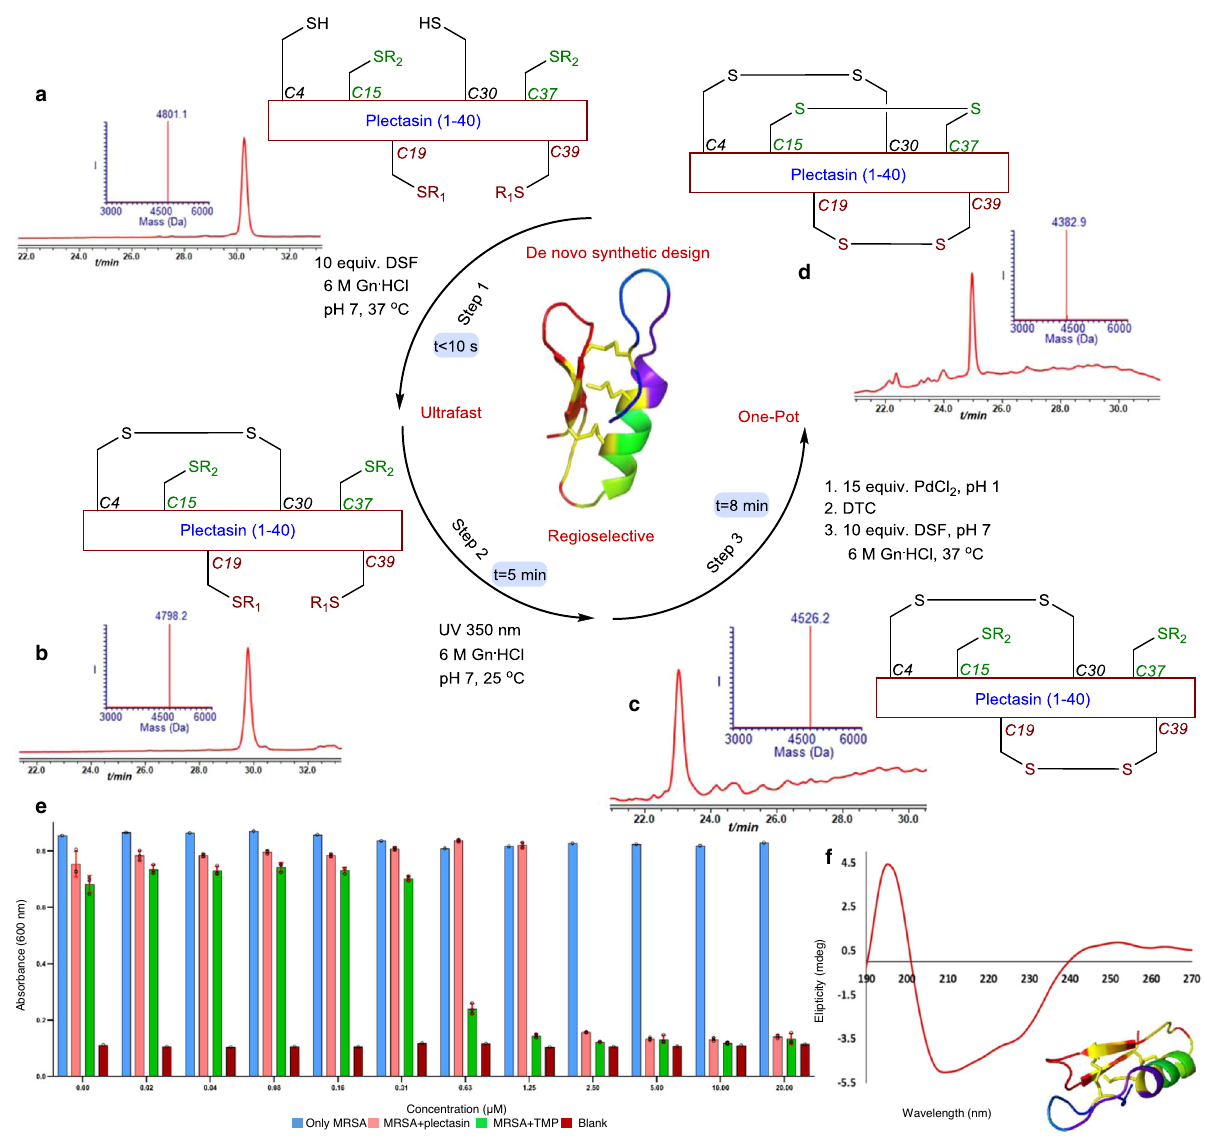
Fig. 4 Synthesis of plectasin employing our synthetic design. a HPLC-ESI MS analyses Reaction at time zero, the main peak corresponds to reduced plectasin with the observed mass 4801.1 ± 0.1 Da, calcd. 4801.0 Da (average isotopes). b Reaction after 10 s: the main peak corresponds to plectasin